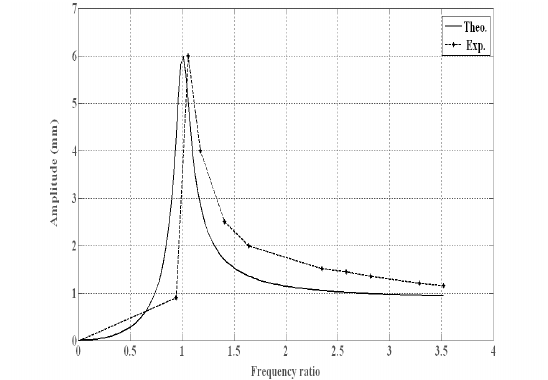
Fig .9. Shows the varaition of the amplitude versus frequency ratio for m=0.284 kg, and e=0.12 m.